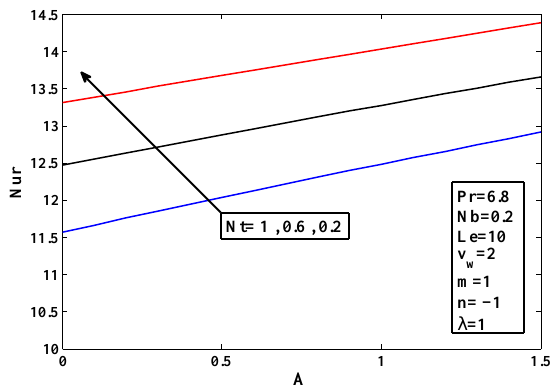
Figure 17: Effect of thermophoresis parameter Nt on the reduced Nusselt number Nur .